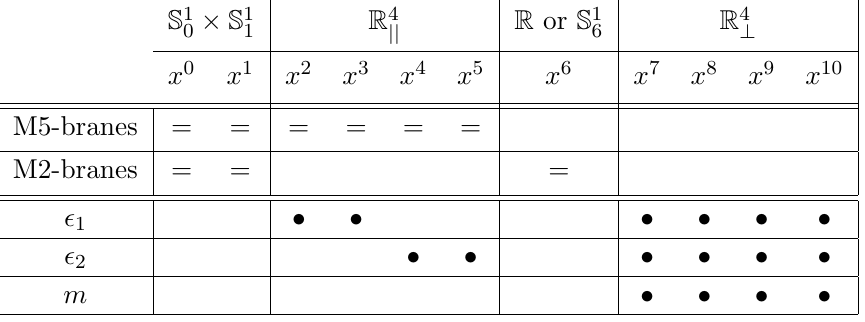
Table 3 . U(1) twists alowing for deformations of the BPS con(cid:12)gurations of M5- and M2-branes. (cid:15) (cid:15)